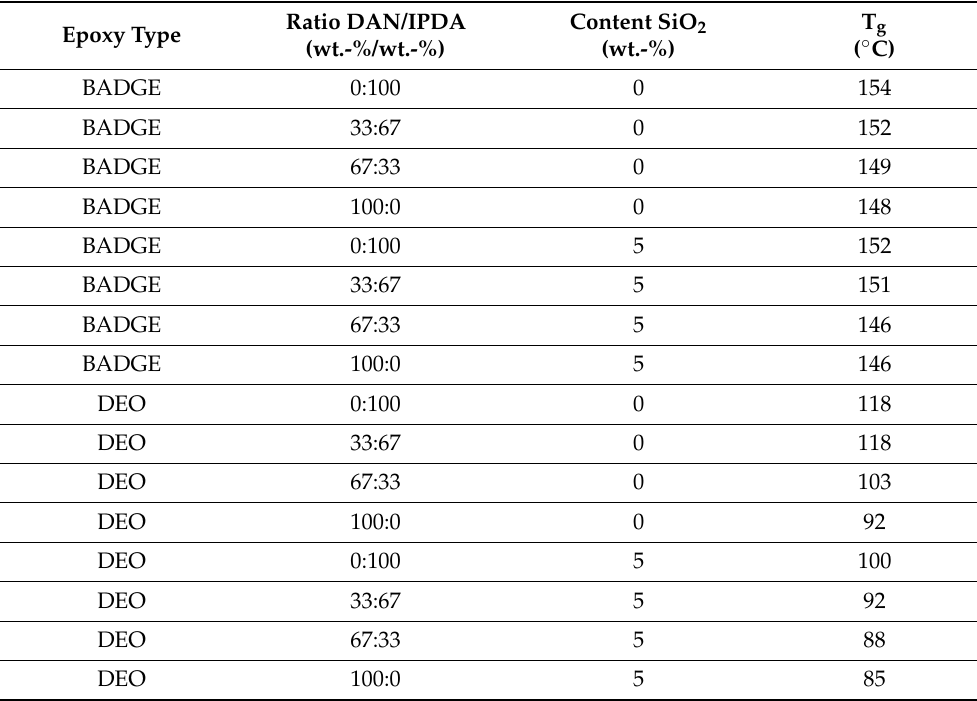
Table 1. Glass-transition temperatures of the bisphenol A diglycidyl ether (BADGE-) and 1,2,7,8- diepoxyoctane (DEO)-based epoxy-amine blends and composites with varying contents of diamine- based hardeners. IPDA, isophorone diamine; DAN, o